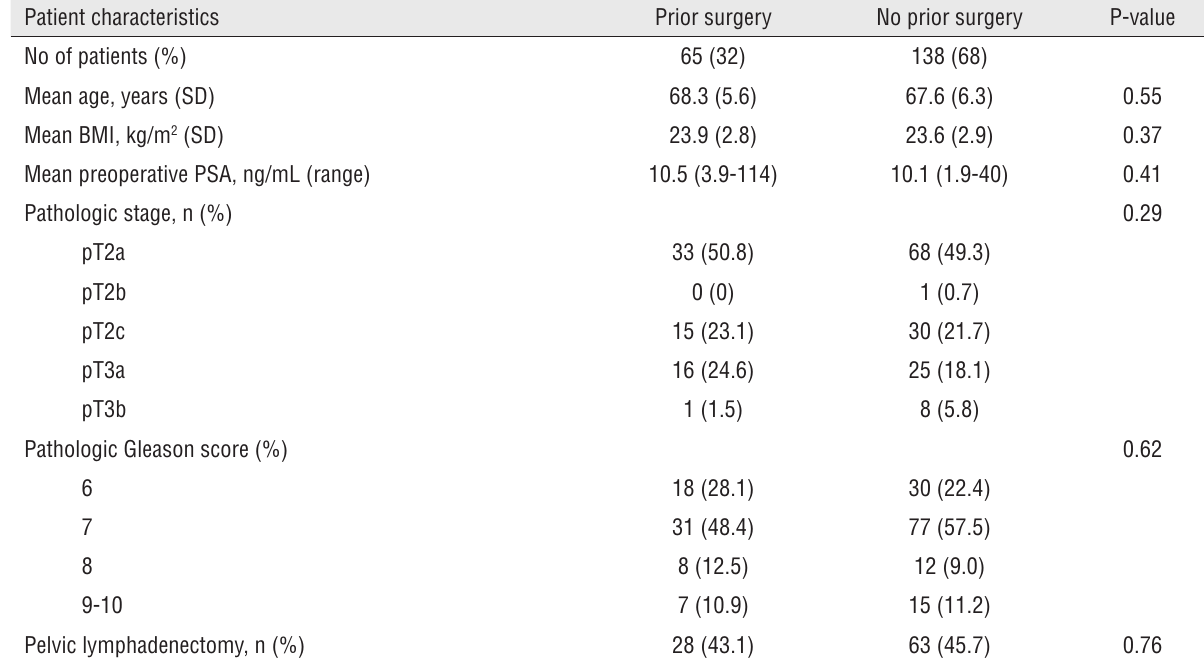
Table 2 - Comparison of patients with or without prior abdominal